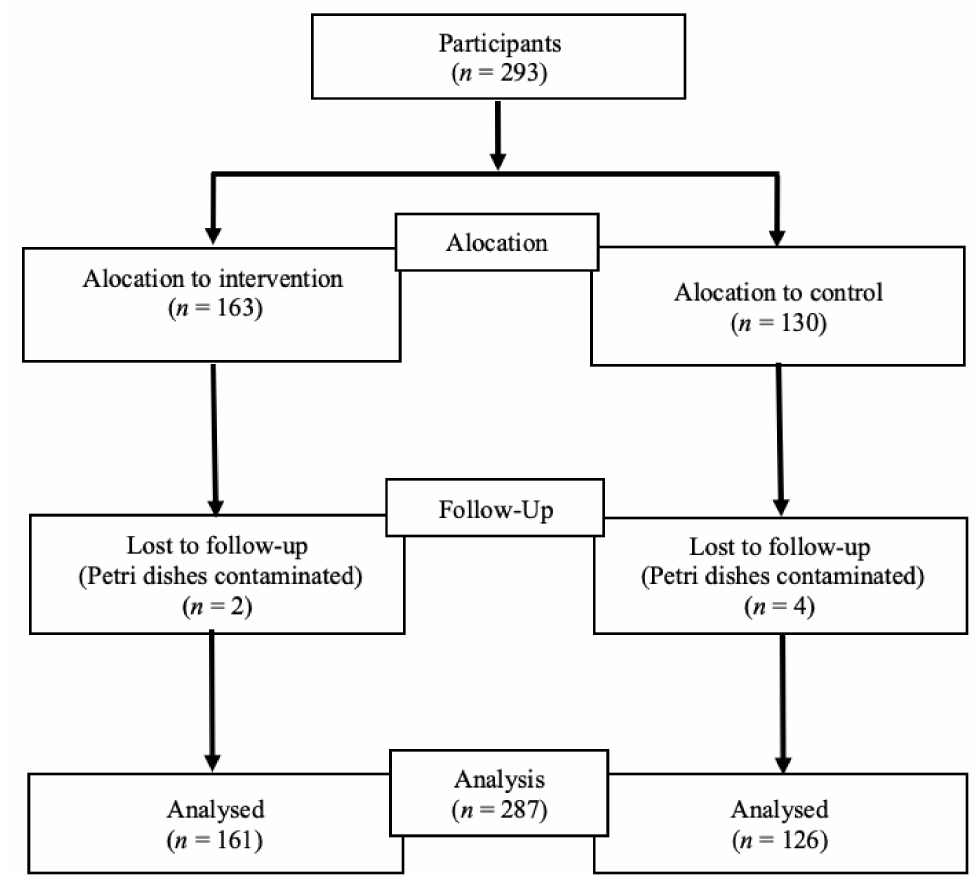
Figure 1. The group selection